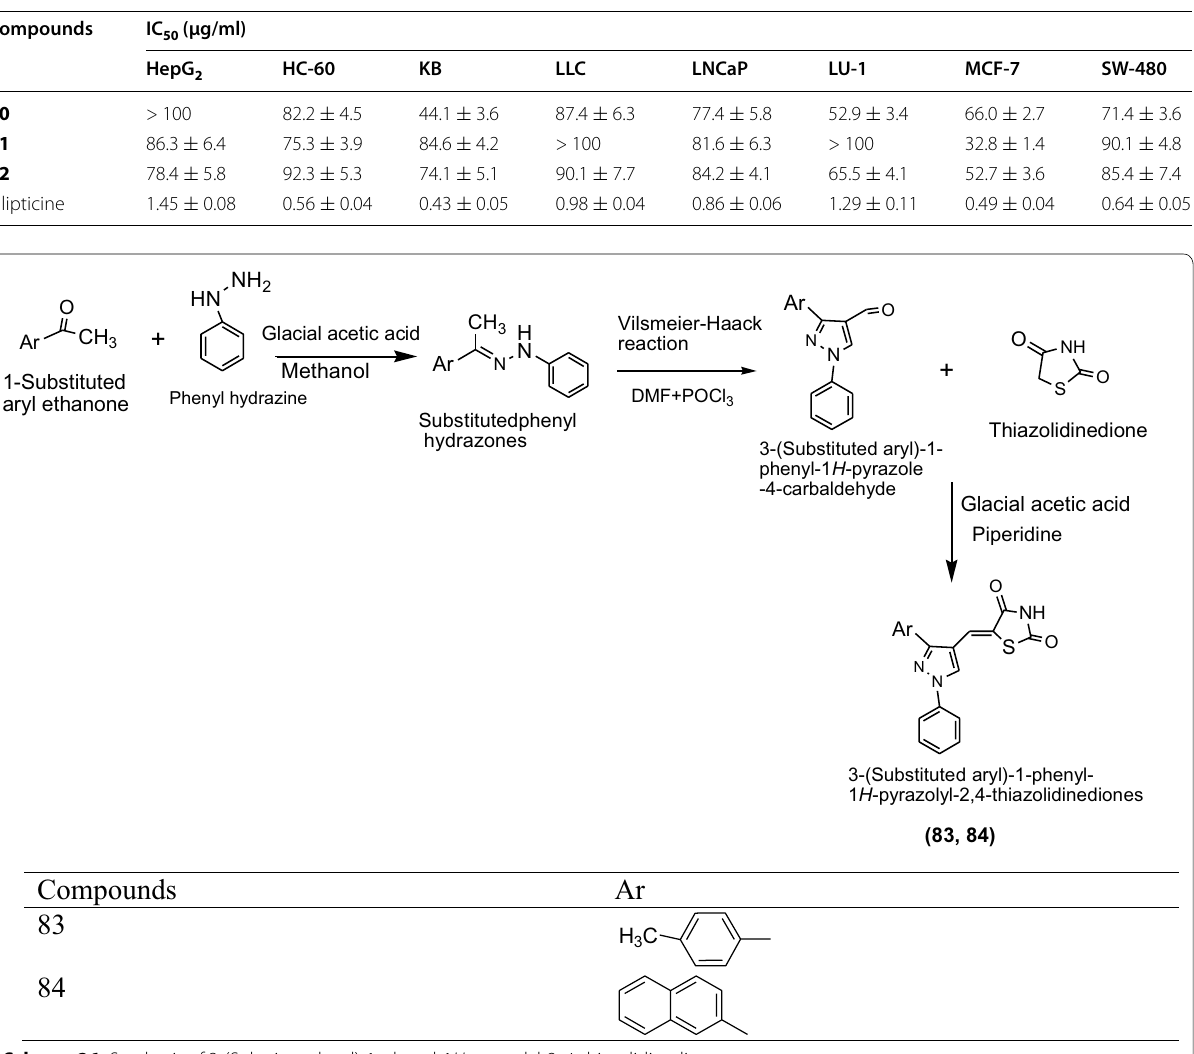
Table 26 Cytotoxicity of synthesized thiazolidinediones